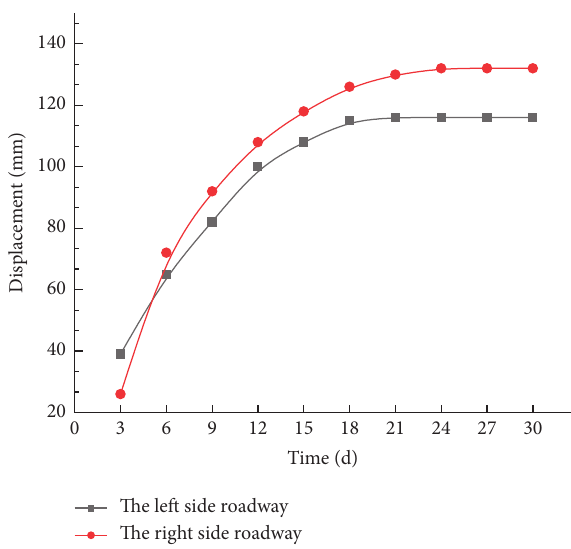
Figure 18: The displacement of the two sides.